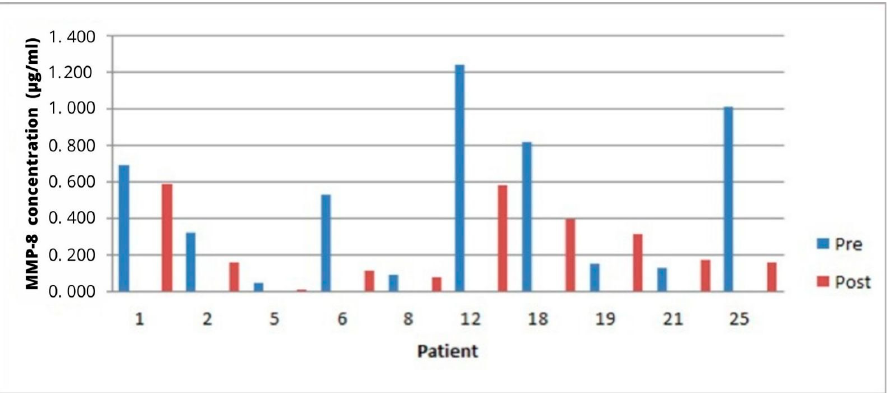
Figure 5. ELISA analysis of the patient’s salivary MMP8 concentration before and after surgery.